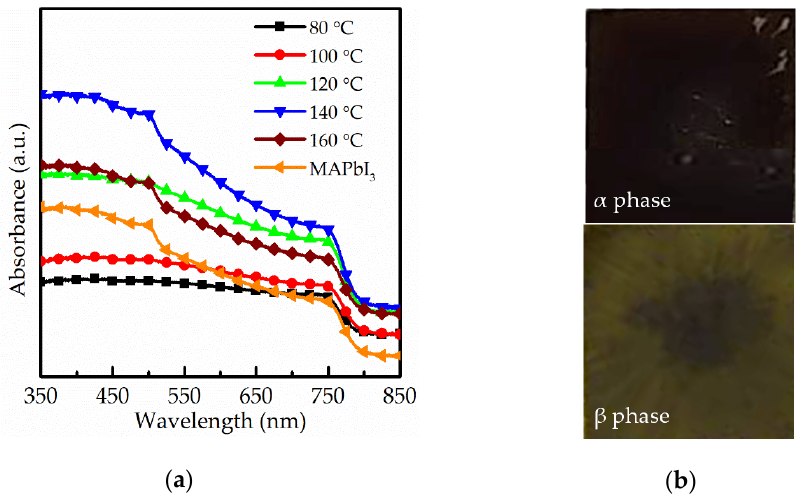
Figure 3. ( a ) Absorption spectrum for CsPbI 3 -QDs doped perovskite thin films under different annealing temperatures and pure perovskite (MAPbI 3 ). ( b ) The morphology of the CsPbI 3